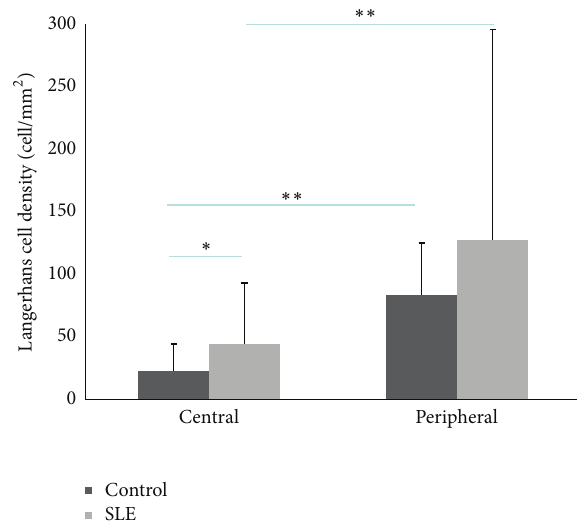
Figure 3: Diagram of the corneal Langerhans cell density in the central and peripheral areas. Centrally significantly greater value was shown in patients with SLE than in control group ( ∗ 𝑃 < 0.05 , Mann-Whitneytest),buttherewasnosignificantdifferencebetween SLE and control group in the periphery. Note the difference between central and peripheral densities both in controls and in patients with SLE ( ∗∗ 𝑃 < 0.05 difference, Wilcoxon